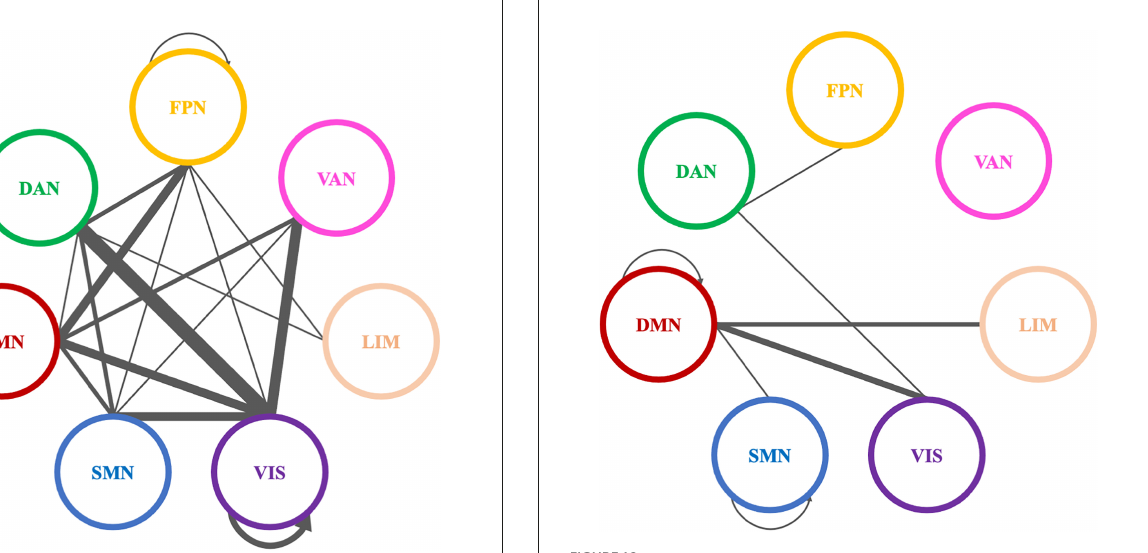
FIGURE8 Significantly modified connections of theta PLI networks across time (T0, T1, T2), between or within the seven resting state networks (RSNs; Thomas Yeo et al., 2011). Line weight corresponds to number of significant connections. Most changes were observed in connections between visual network and other RSNs, between default mode network and frontoparietal network or within the visual network. DAN, dorsal attention network; DMN, default mode network; LIM, limbic network; FPN, frontoparietal network; SMN, somatomotor network; VAN, ventral attention network; VIS, visual network.